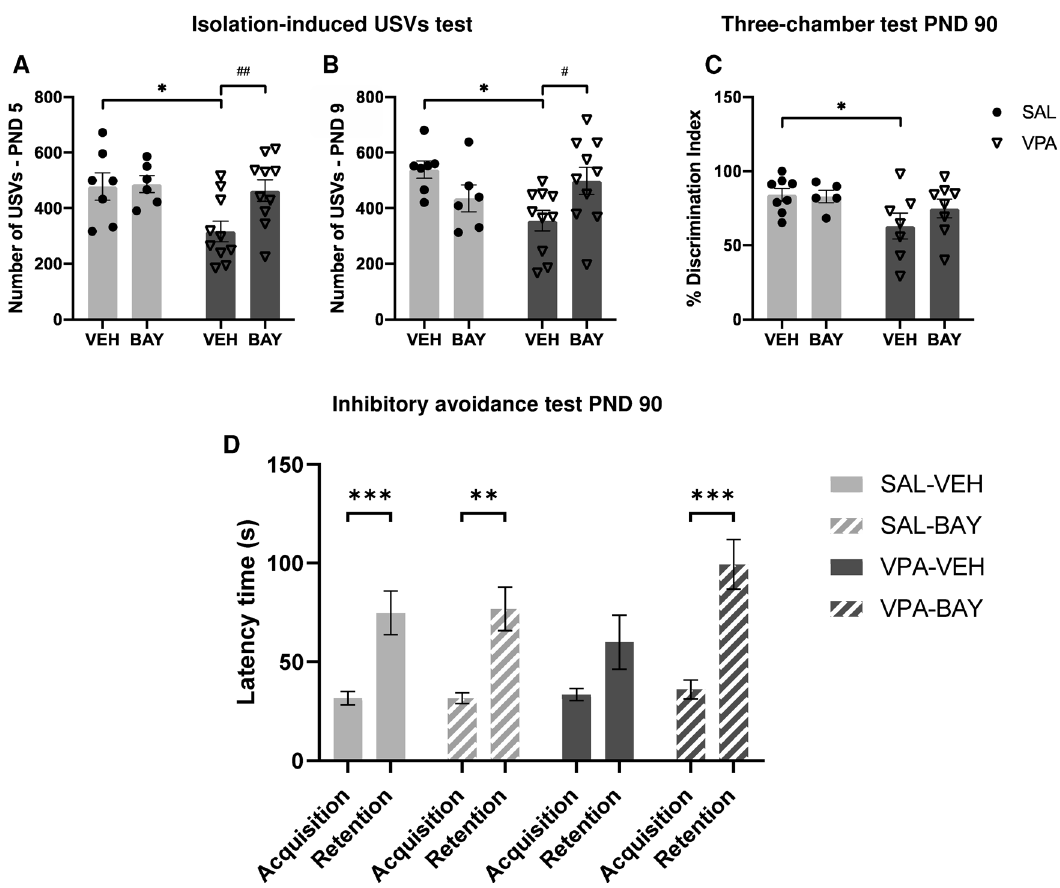
Fig. 5 Pharmacological inhibition of PDE2A normalizes the communicative, social and cognitive de fi cits displayed by VPA-exposed rats. PDE2A inhibition by BAY607550 normalizes the altered USV pro fi le displayed by VPA-exposed pups both PNDs 5 ( A ) and 9 ( B ) (PND 5: SAL- VEH, n = 7; SAL-BAY, n = 6; VPA-VEH, n = 10; VPA-BAY, n = 10, PND 9: SAL-VEH, n = 7; SAL-BAY, n = 6; VPA-VEH, n = 10; VPA-BAY, n = 10). Moreover, administration of BAY607550 rescues the lower discrimination index displayed by VPA-exposed rats in the three-chamber test ( C ) (SAL-VEH, n = 8; SAL-BAY, n = 5; VPA-VEH, n = 7; VPA-BAY, n = 8). At adulthood, VPA-exposed rats present impaired consolidation of aversive memories, that is reversed following administration of BAY607550 ( D ) (SAL-VEH, n = 31; SAL-BAY, n = 30; VPA-VEH, n = 16; VPA-BAY, n = 16). Data represent mean ± S.E.M. * p < 0.05 vs SAL-VEH group, # p < 0.05, ## p < 0.01 vs Fmr1- Δ exon 8 -VEH group (Student ’ s – Newman – Keuls post hoc test); ** p < 0.01, *** p < 0.001 vs acquisition time (Student ’ s – Newman – Keuls post hoc